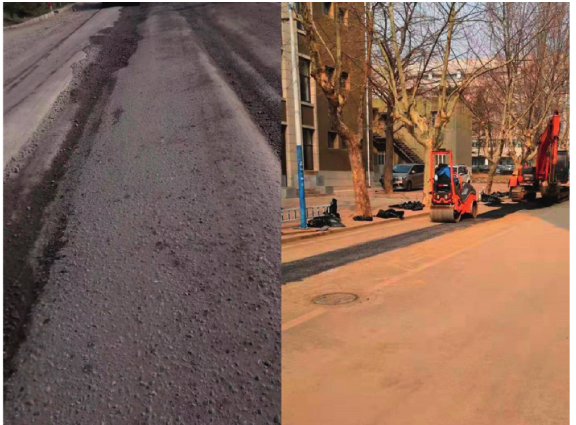
Figure 3: Anomalies on the